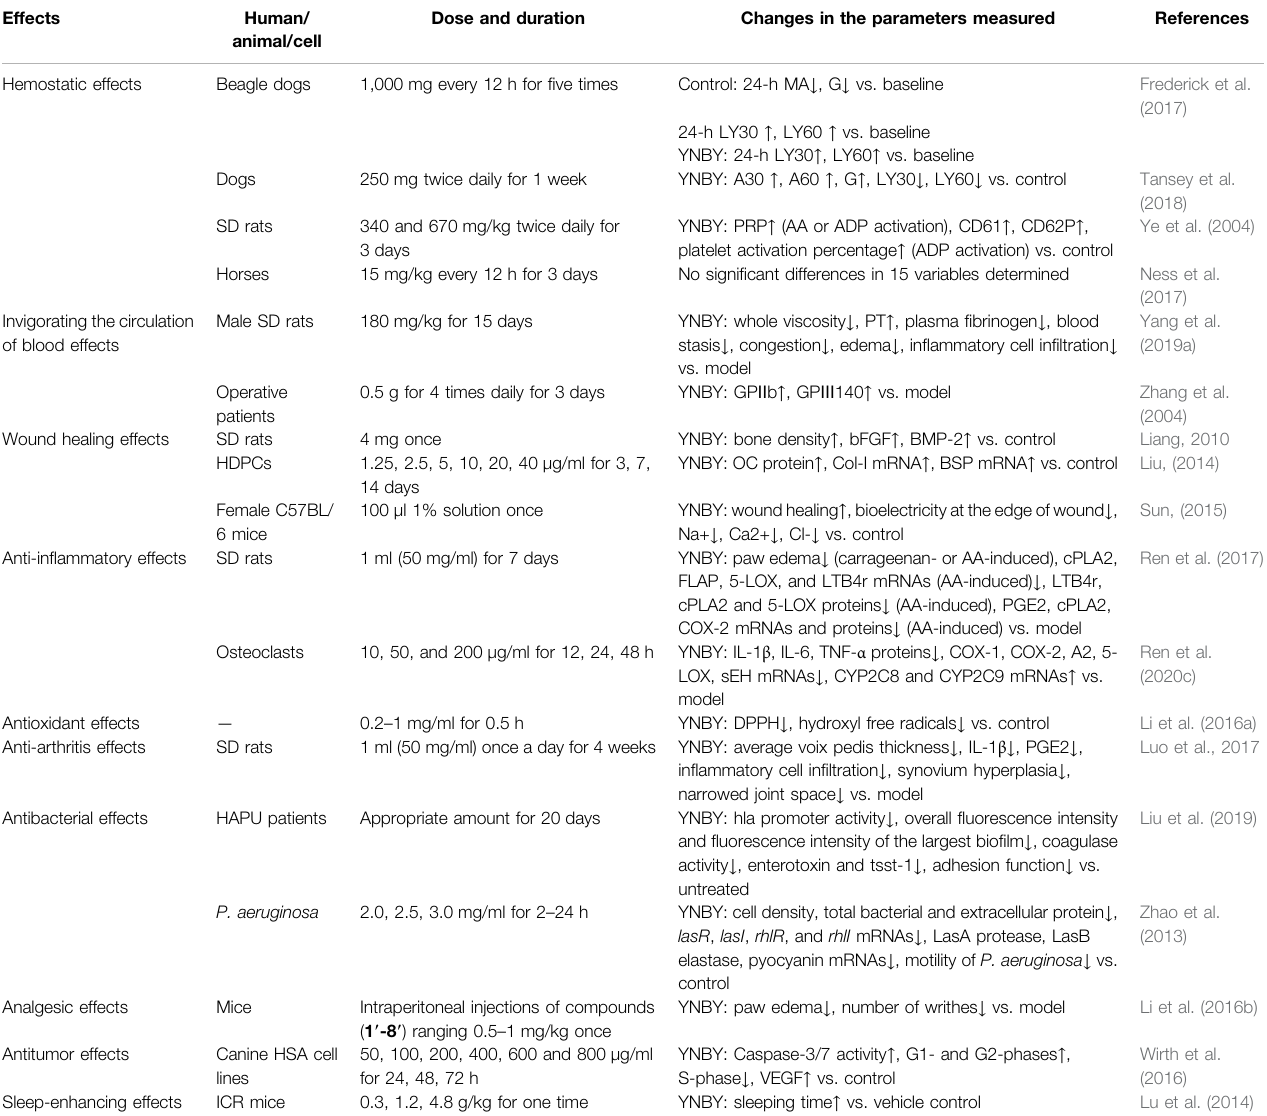
TABLE 1 | Pharmacological effects of